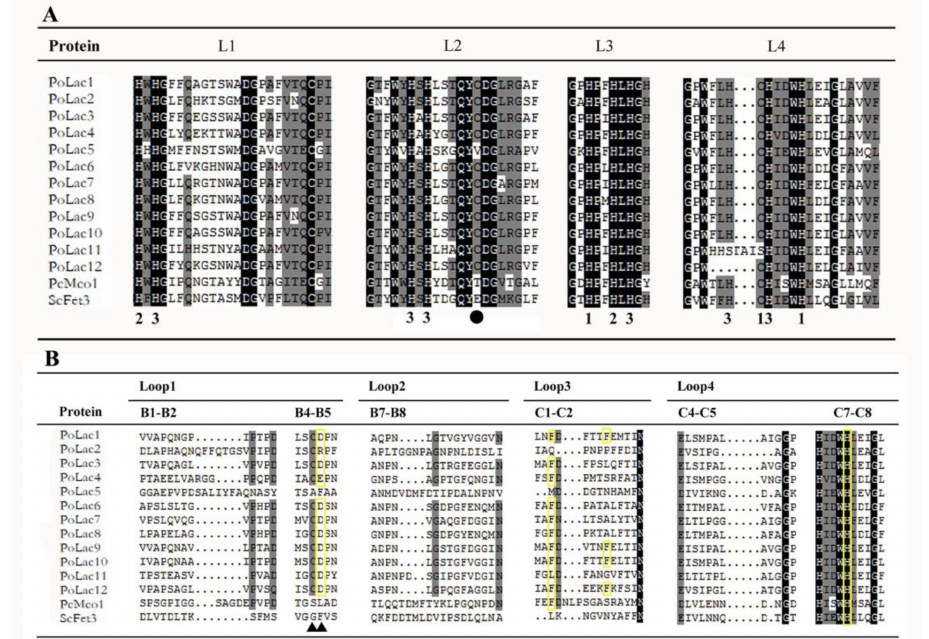
Figure 2. The signature sequences ( A ) and the postulated substrate binding loops ( B ) of P. ostreatus laccases Lac1 to Lac12 with the corresponding sequences from laccase Mco1 of P. chrysosporium